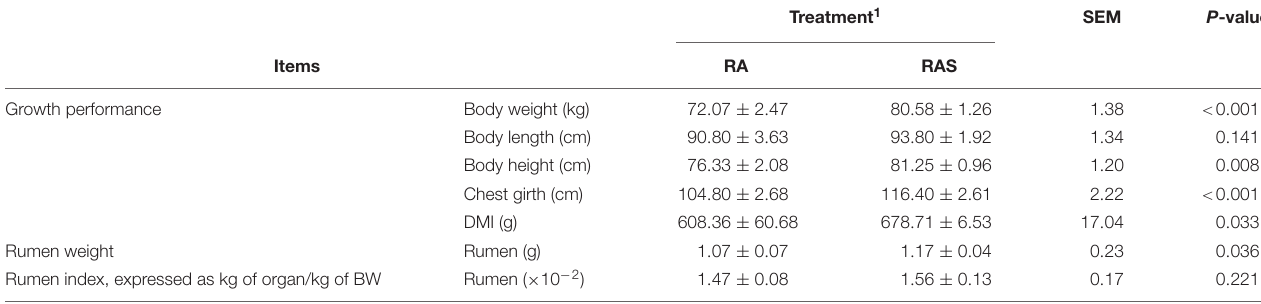
TABLE 2 | Effects of the starter feeding supplementation in the preweaning period on the growth performance and development of rumen in yak